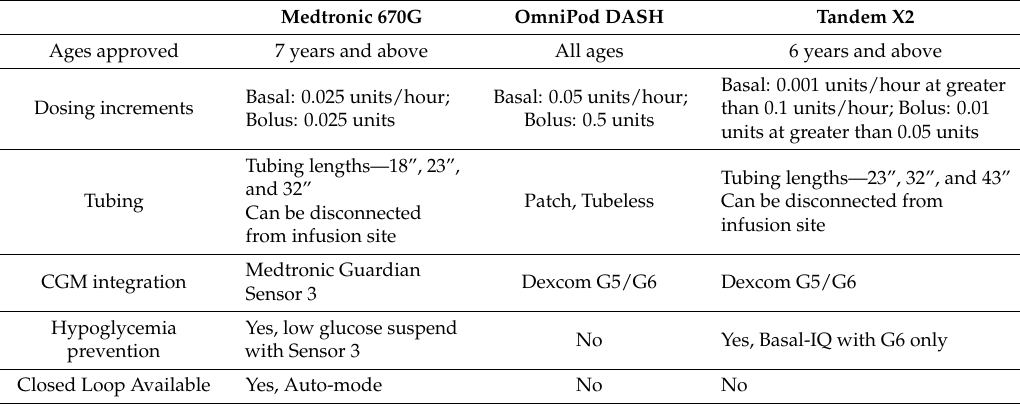
Table 2. An overview of currently available insulin pump systems within the